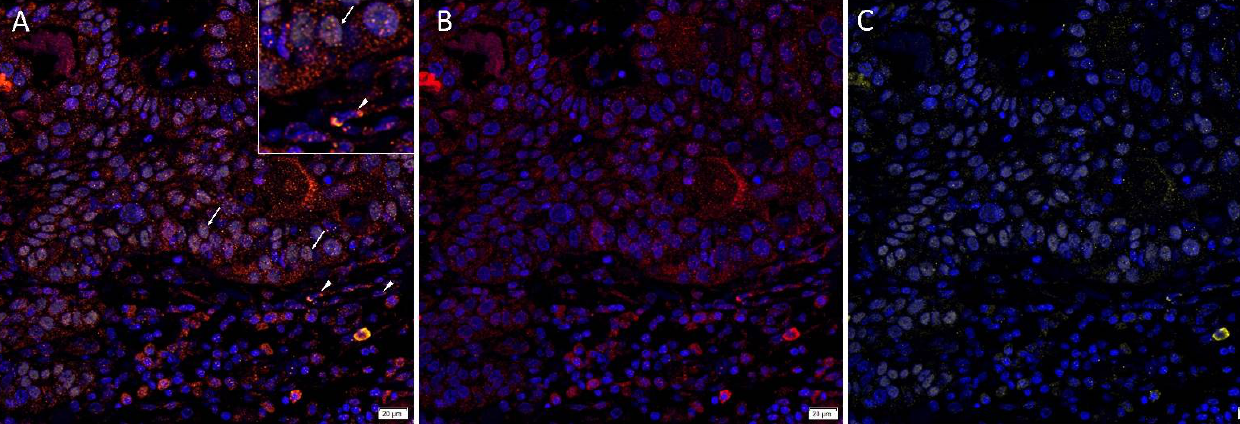
Figure 5. Representative merged and split immunofluorescence-stained sections of metastatic head and neck cutaneous squamous cell carcinoma demonstrating the expression of AT 2 R ( A , B , red) in the cytoplasm and nucleus of the SOX2+ ( A , C , yellow) CSCs within the TNs ( arrows ) and the PTS ( arrowheads ). Cell nuclei were counter-stained with 4′6-diamidino- 2-phenylindole ( A – C , blue). The inserts show enlarged views of the corresponding images Original magnification 400×. n = 2.